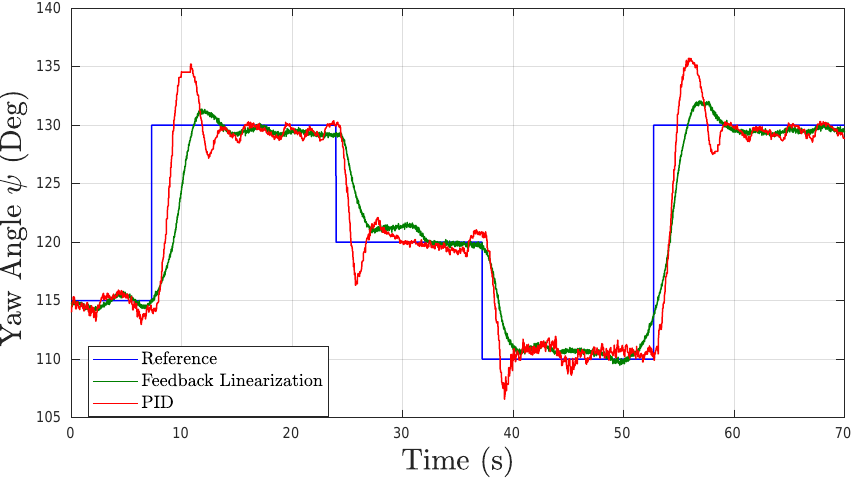
Figure 11. Experimental results obtained in underwater tests in Yaw.